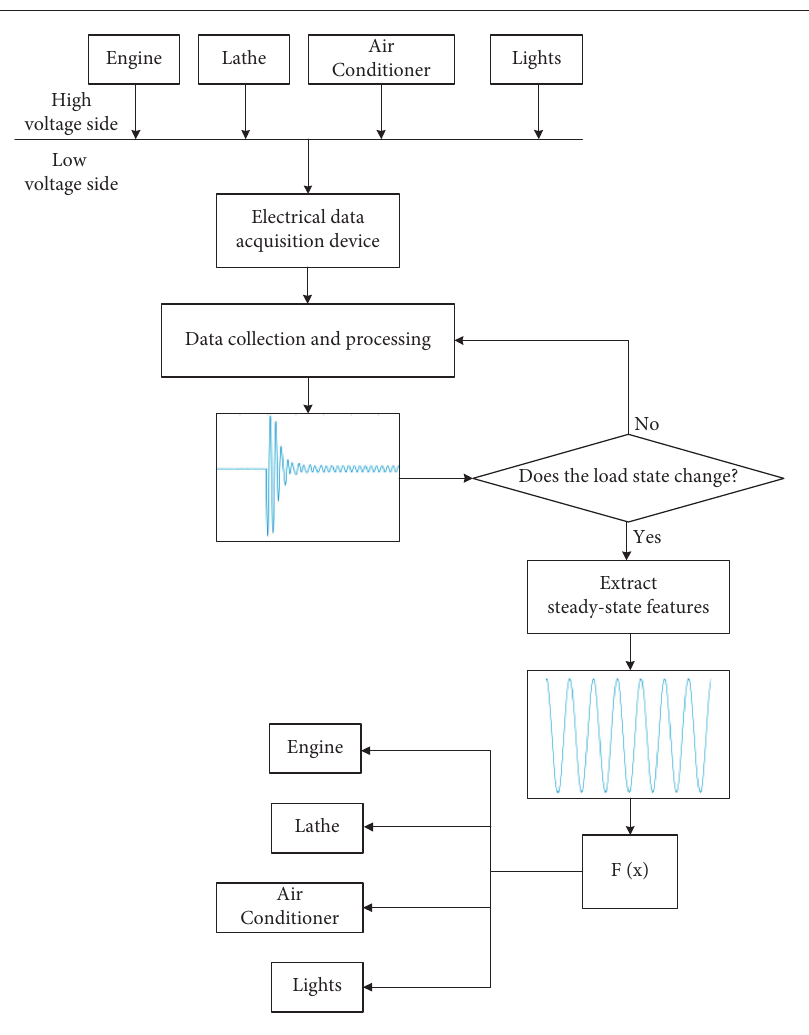
Figure 1: Nonintrusive industrial load